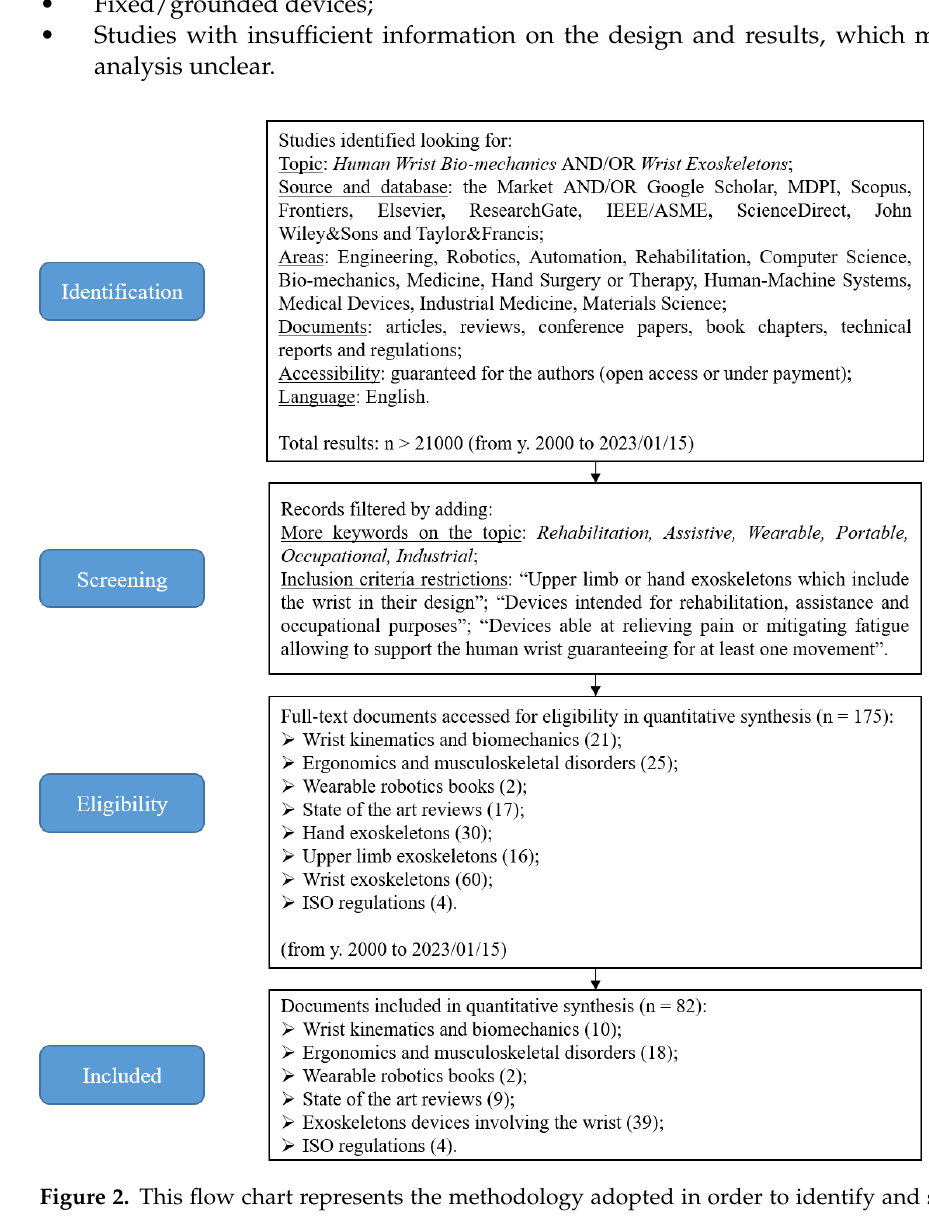
Figure 2. This flow chart represents the methodology adopted in order to identify and screen all information available from online database and conduct our